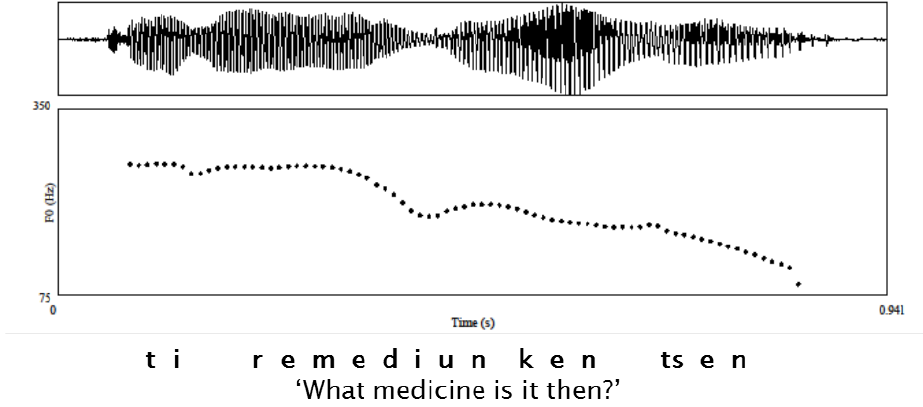
Figure 2. A Cha’palaa content question, showing an initial high accent falling to a low boundary tone